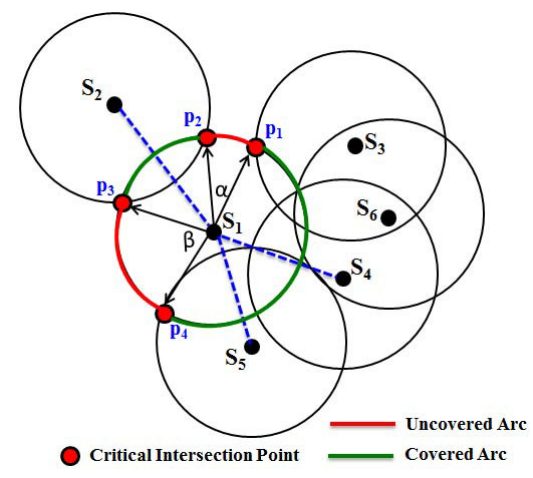
Figure 6. Construction of covered and uncovered arcs.